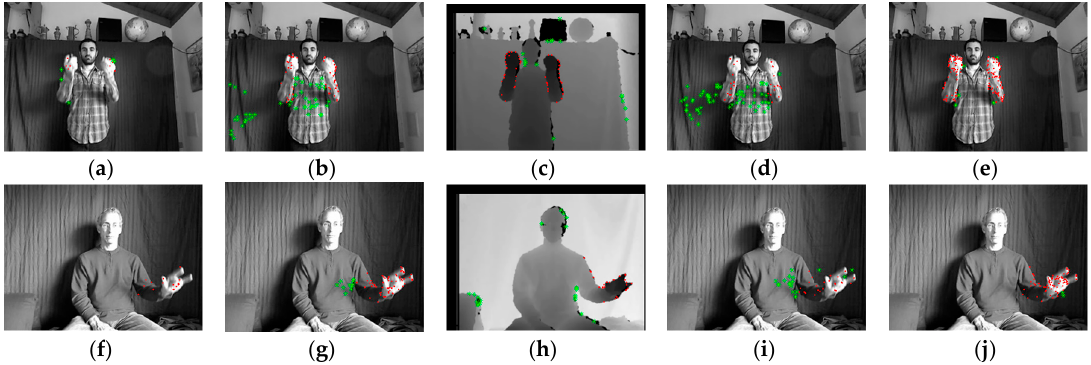
Figure 5. Keypoints detected by different spatiotemporal feature approaches. ( a , f ) The keypoints detected by 3D EMoSIFT; ( b , g ) The keypoints detected by 3D SMoSIFT4; ( c , h ) The keypoints detected by 3D SMoSIFT2; ( d , i ) The keypoints detected by MFSK; ( e , j ) The keypoints detected by the proposed approaches. Red points denote the keypoints detected from MBPs. Falsely detected keypoints are marked as green asterisks.